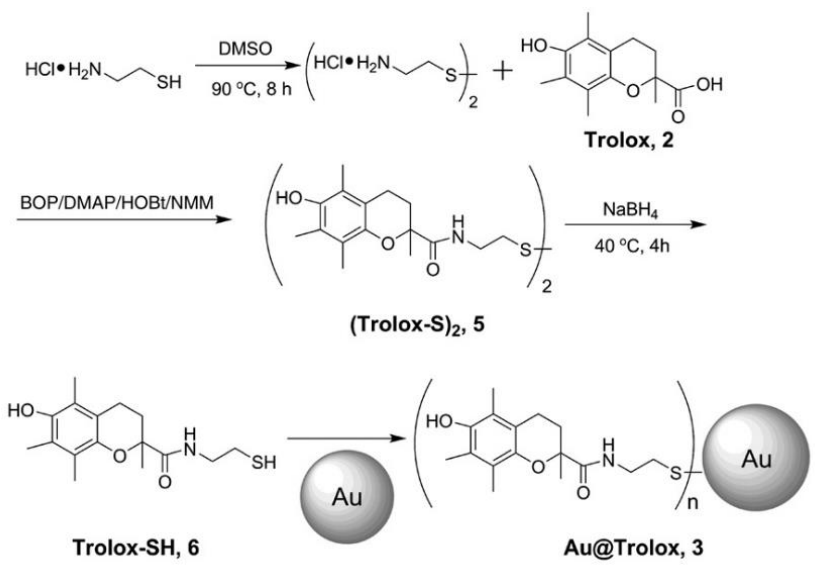
Figure 19. Schematic depiction of the synthetic procedure used to prepare Au@Trolox nanoantioxi- dant. Reprinted (adapted) with permission from [38].